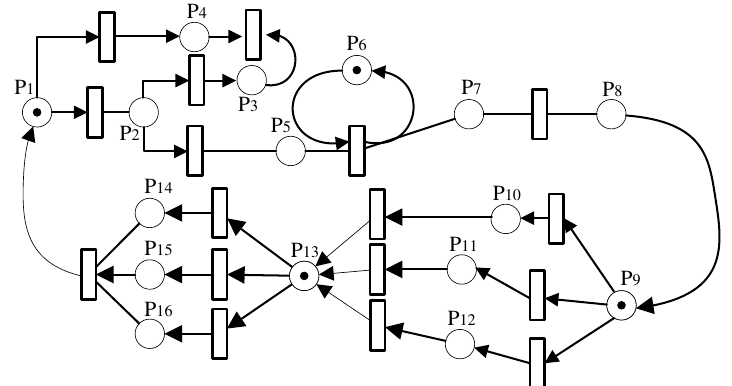
Figure 2. The virtual-real interactive Petri net model of oil and gas